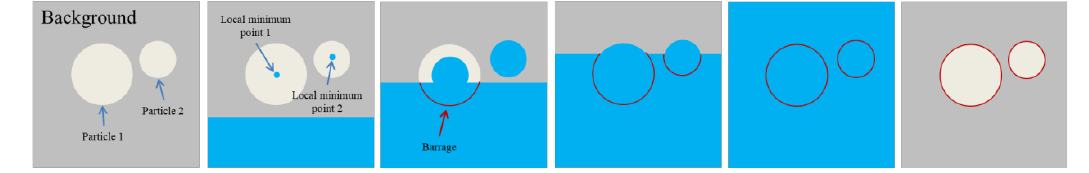
Figure 2. Principle of MW.